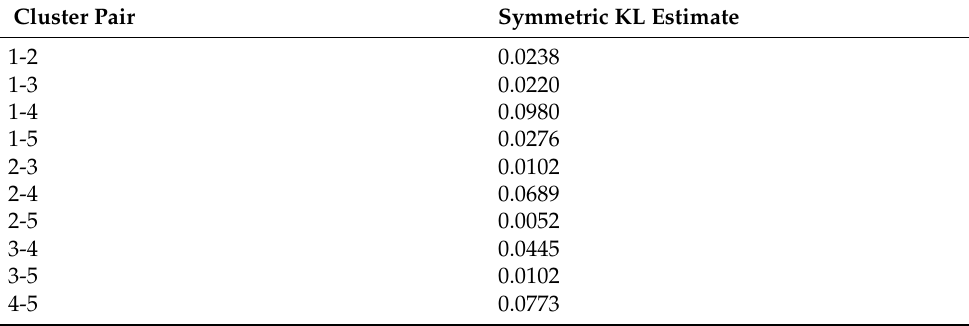
Table A7 shows the estimates of the symmetric KL divergences, using the histogram functions in Figure 9 as a plug-in density estimator. These divergences represent the information lost between the two RT score distributions and measure how similar they are, where a divergence of zero means they are identically distributed. We see that clusters 1, 2 and 5 distributions are very similar, where cluster 3’s distribution is somewhat less similar. The most different distribution is cluster 4. Table A7. Symmetric KL divergence estimates for a pairwise comparison of each cluster’s risk tolerance score. The left-hand column shows that the distribution is being compared to the reference distribution in the first